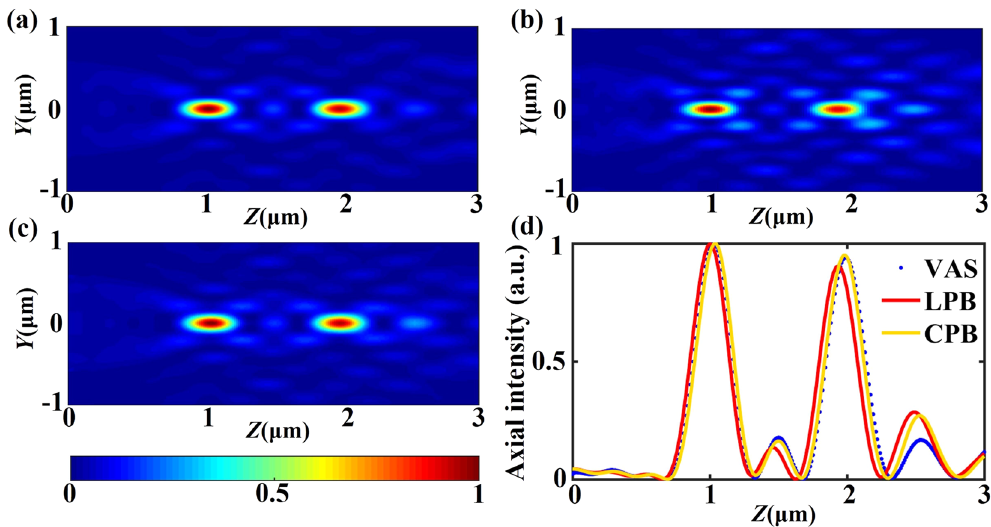
Figure 3. ( a ) The calculated electric-field pattern based on the VAS theory. ( b–c ) The simulated electric-field patterns at the Y-Z plane with LPB and CPB illumination, respectively. ( d ) Comparison of the axial intensity distributions for SOL #1 calculated via the VAS theory (blue dot), FDTD method with LPB (red solid line) and FDTD method with CPB (yellow solid line),